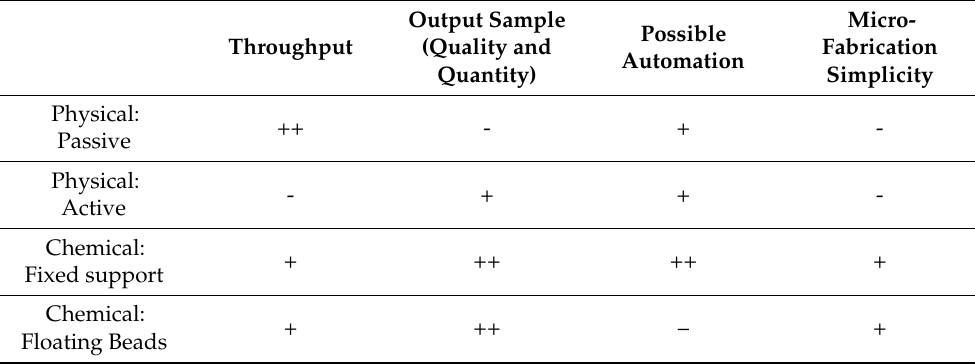
Table 3. Summary of the comparison of different microfluidic techniques for EV isolation. Each of the four aspects is evaluated according to the following scale: (–) difficult/very bad, (-) non- trivial/mediocre, (+) easy/good, (++) very